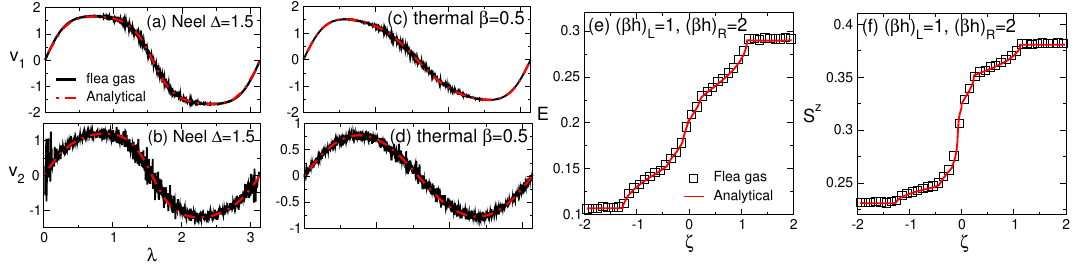
Figure 4: Flea gas versus GHD results. Panels (a) and (b) show the dressed group velocities v α for the first two strings plotted versus the quasiparticle rapidity λ . The , λ black line is the flea gas result. The data are for a chain with L = 2000 sites and are averaged over 10 3 realizations of the dynamics. The dash-dotted line is the solution of (23). The results shown are for the quench from the Néel state and ∆ = 1.5. Panels (c) and (d) show the values of v and v for the quench from the initial thermal 1 2 density matrix (31). Panels (e) and (f) show profiles of observables in the quench = β = 0, of the XXZ chain with ∆ = 2 from the bipartite thermal state with β L R ( β h ) = 1, ( β h ) = 2, considered in Ref. [ 80 ] . We plot the local energy E and the L R magnetization S z as a function of ζ ≡ x / t . The squares represent the flea gas results averaged over 10 3 realizations of the dynamics. The full line was obtained in [ 80 ] by solving the GHD equations